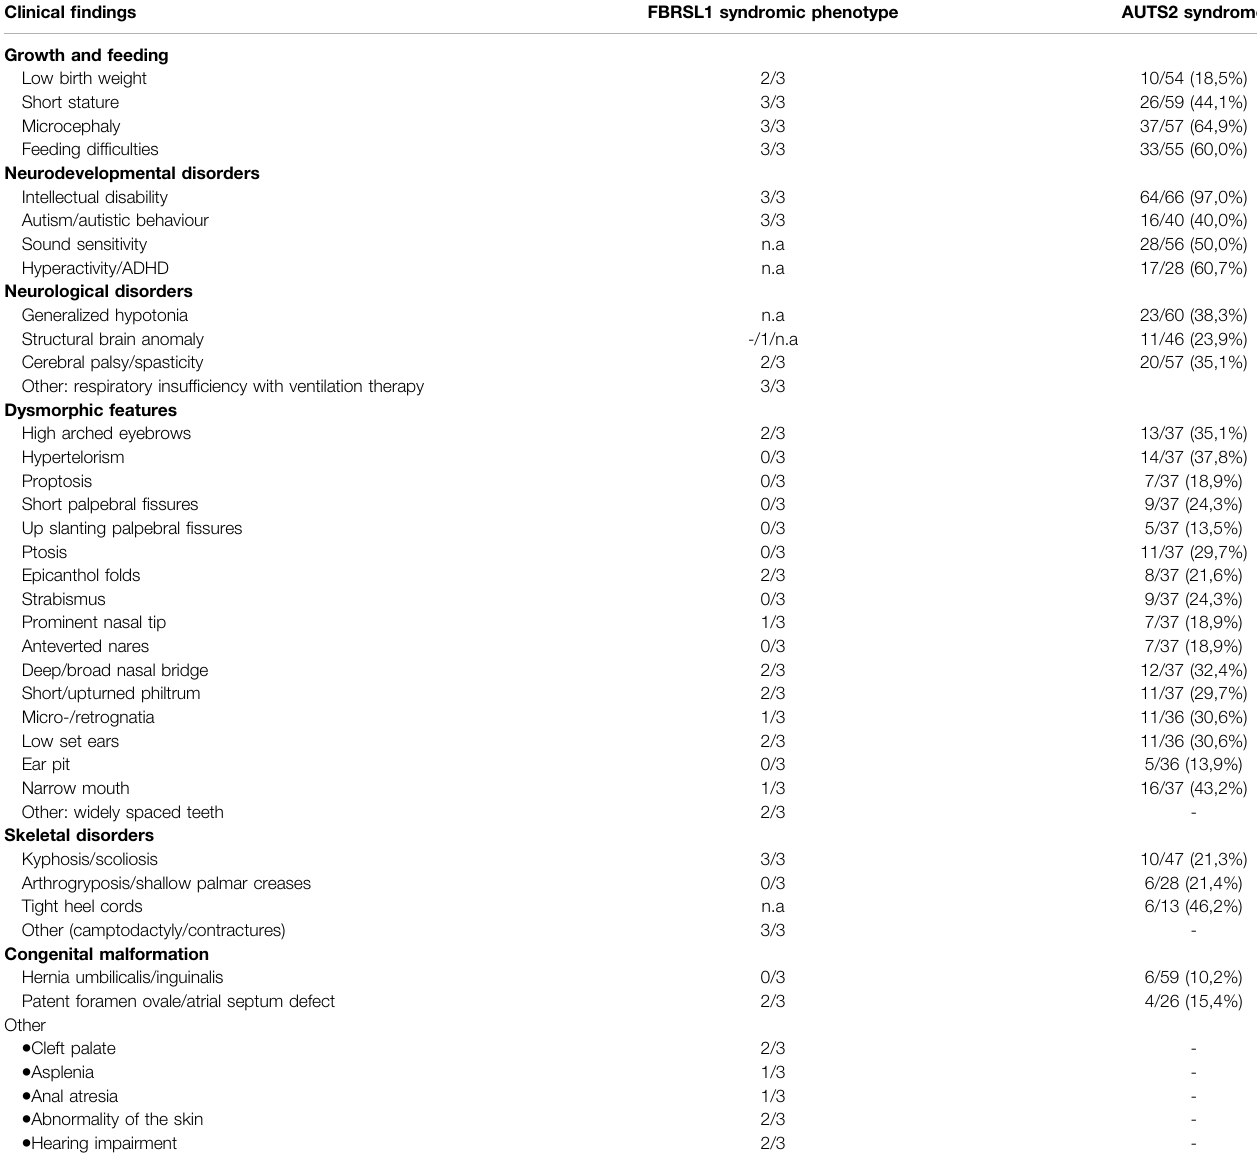
TABLE 1 | Comparison of clinical features seen in patients with FBRSL1 mutation and patients with AUTS2